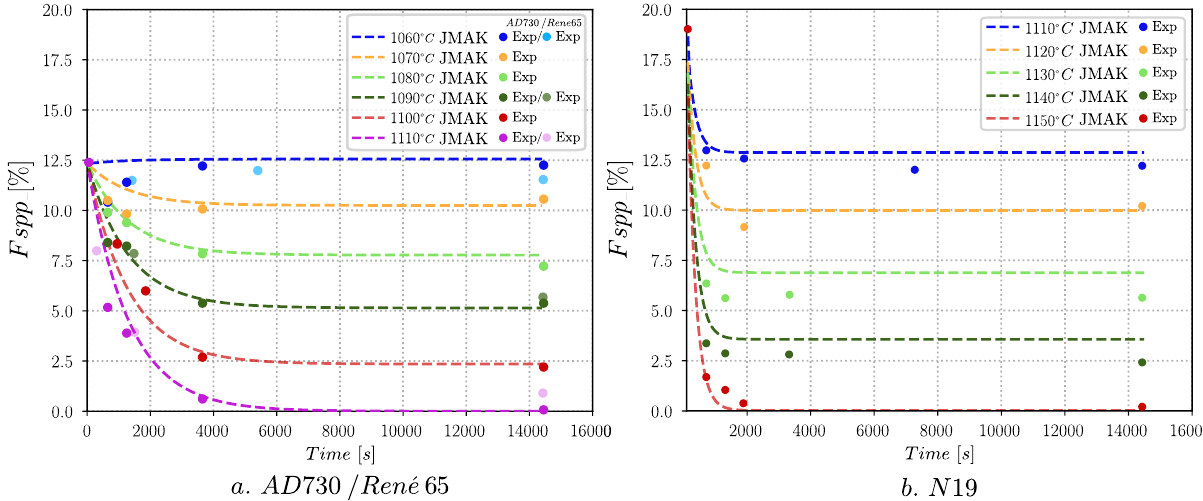
Figure 6. Comparison between the phenomenological model Equation (4) (dashed lines) and experimental results (points) of the primary γ (cid:48) fraction at different times and temperatures for ( a ) René 65 and AD 730 and ( b ) N 19